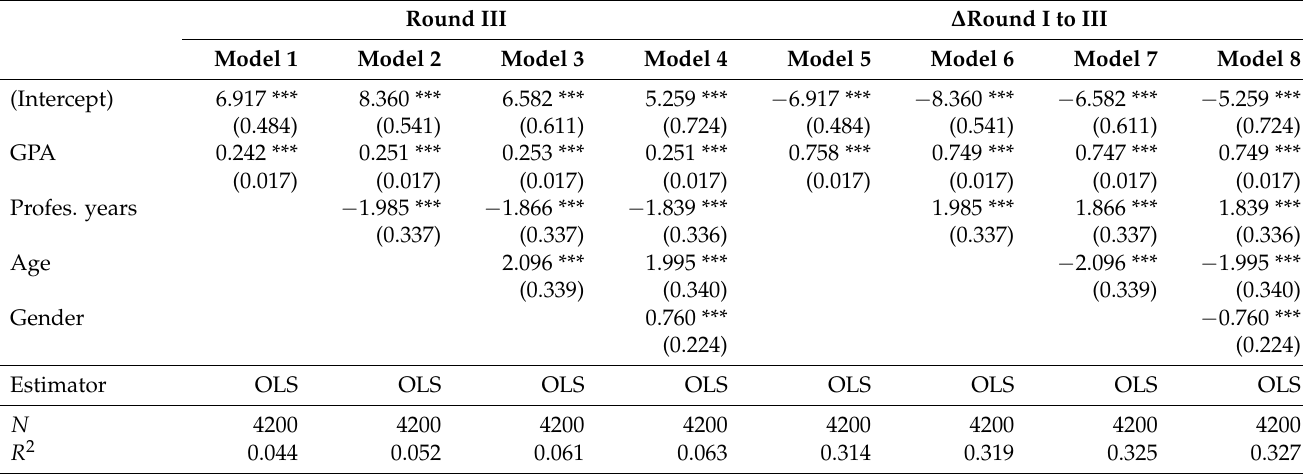
Table 3. Regression